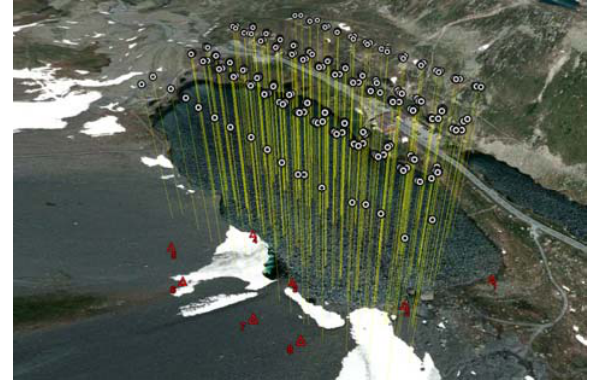
Figure 1: Orthophoto of the Flüelapass. The labelled landforms give in their numbered order a short overview on the geomorphologic history of the site. (orthofoto: swissimage©2014 swisstopo 5704 000 000).